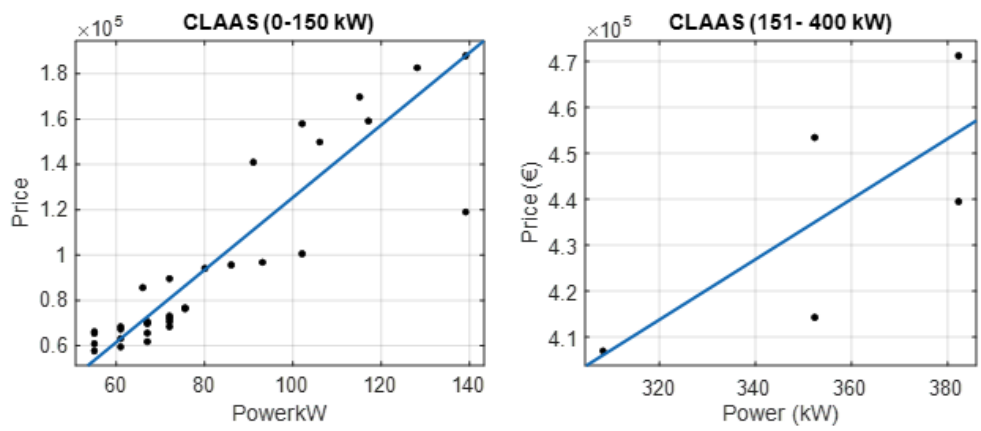
Figure 4. Price vs. power for Case IH new tractors.